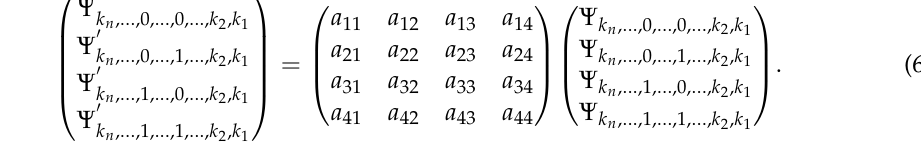
(cid:126) Ψ (cid:48) = ˆ A (cid:126) Ψ